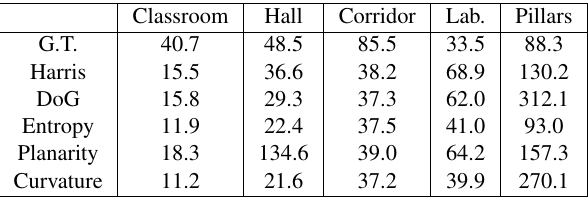
Table 3. RMSE values (in mm) obtained from coarse registration Classroom